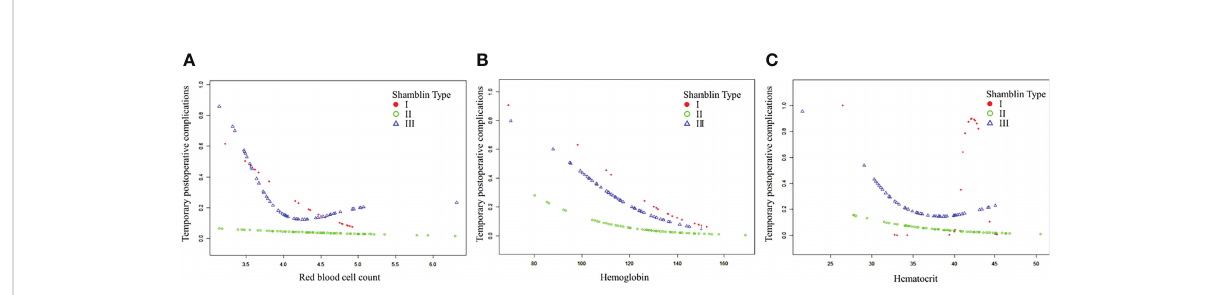
FIGURE 2 The association between blood routine indexes and temporary postoperative complications in patients with CBT with different Shamblin type. CBT, carotid body tumor. (A – C) . The association between postoperative red blood cell, hemoglobin or hematocrit and temporary postoperative complications in CBT patients with different Shamblin type.